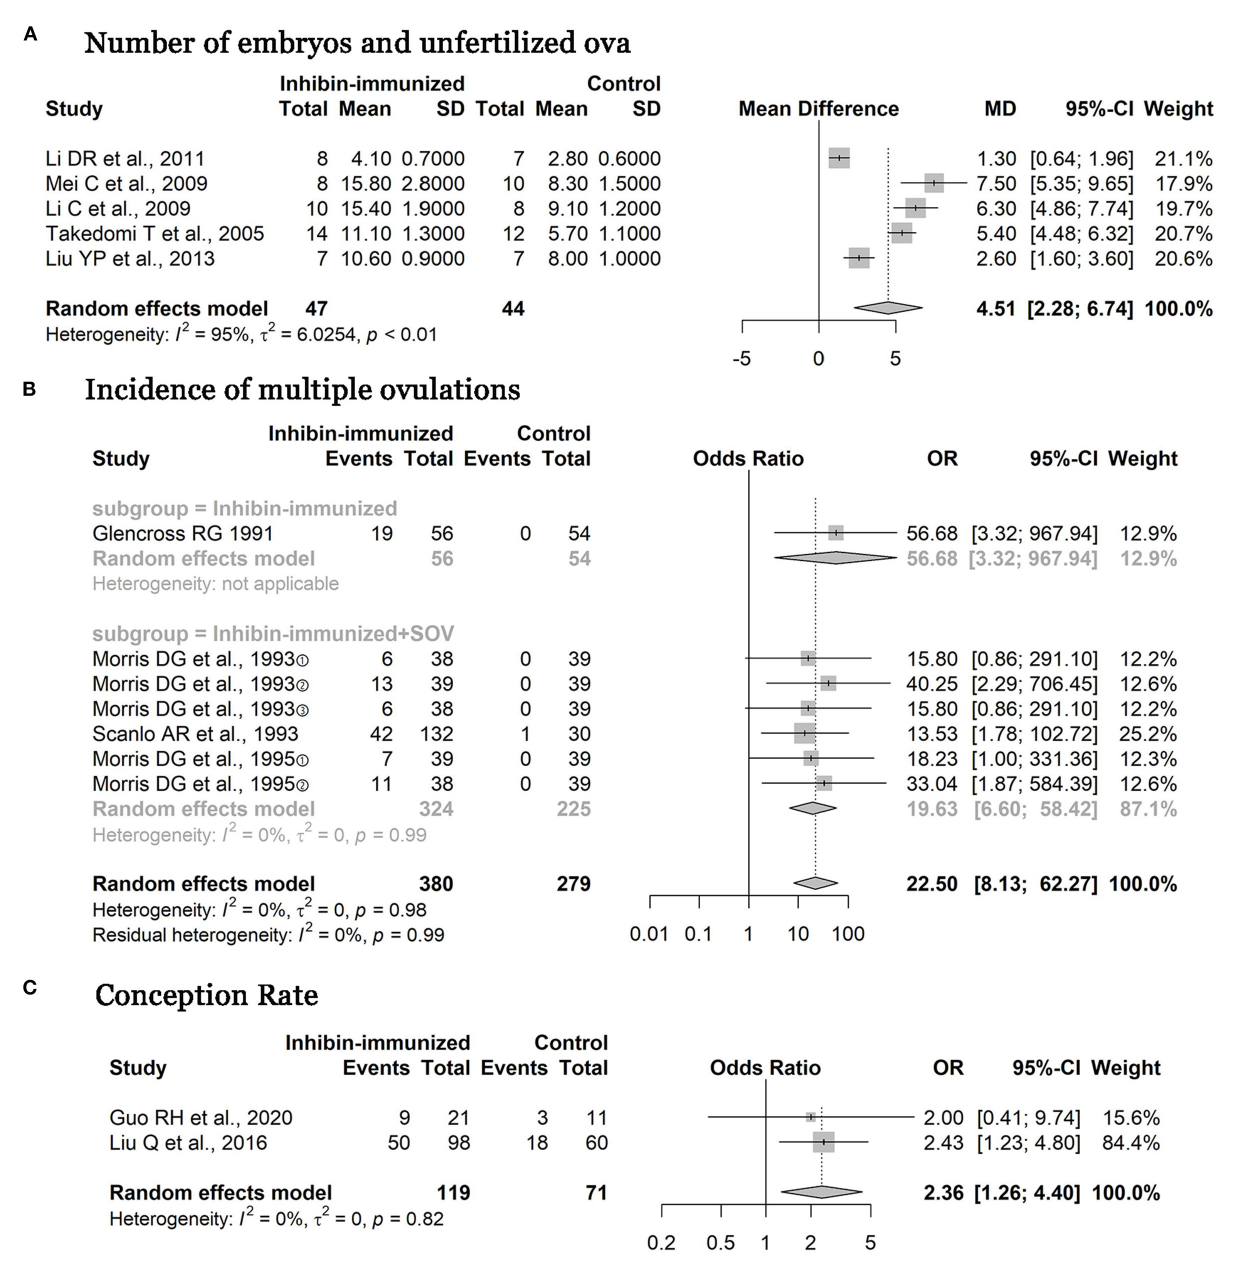
FIGURE 4 | Meta-analysis of number of embryos, unfertilized ova, and incidence of multiple ovulations after treatment and conception rate. SOV,